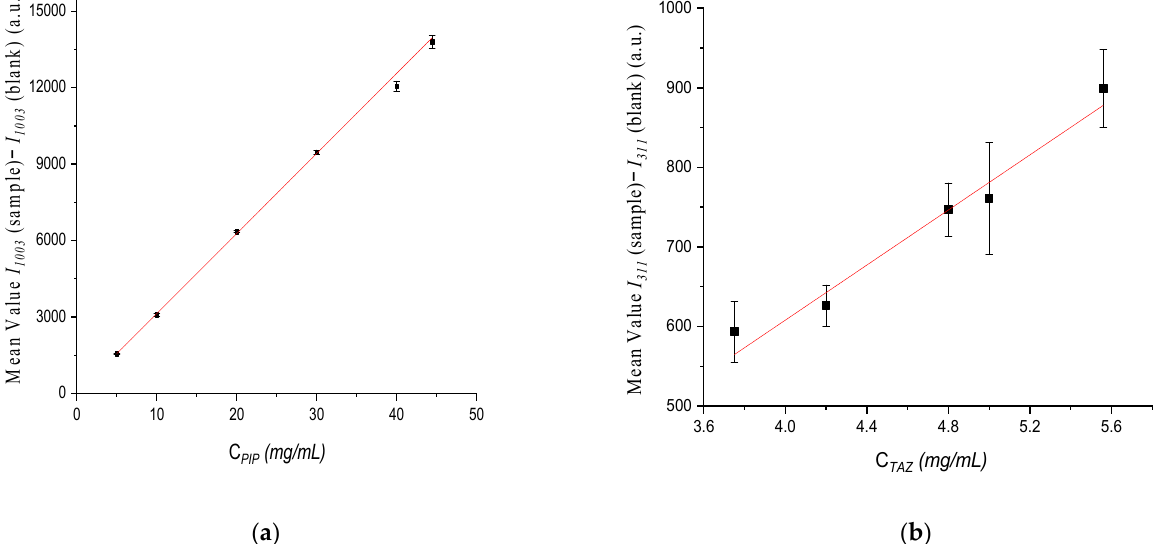
Figure 9. Calibration curve of: ( a ) PIP and ( b ) TAZ, for standard solutions of liquid formulation placed in the Raman optic cell before administration, with concentration values ranging from 44.44 to 5.00 mg/mL for PIP and from 5.56 to 3.75 mg/mL for TAZ respectively.